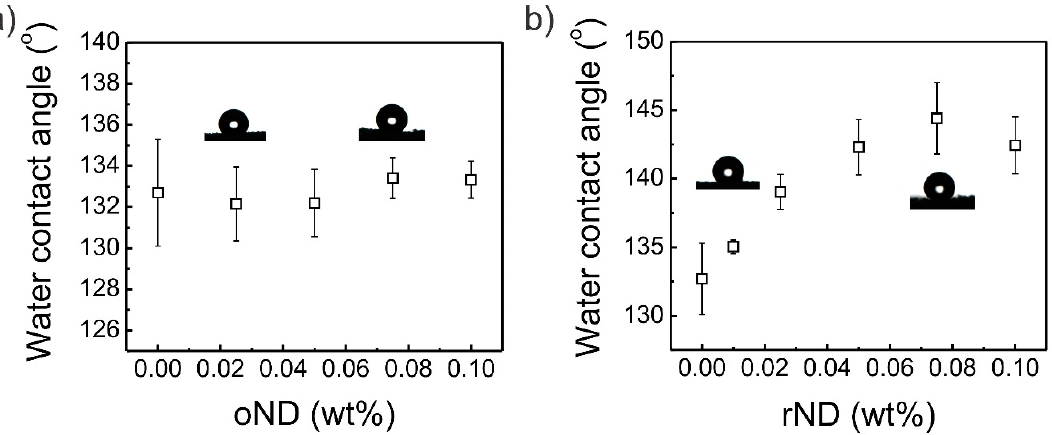
Figure 5. Water contact angle on PDMS / ND composite sponges dependent on the concentration of ( a ) oxidized and ( b ) reduced ND particles. The error bars denote the standard deviation of at least 3 single measurements on the PDMS sponges.